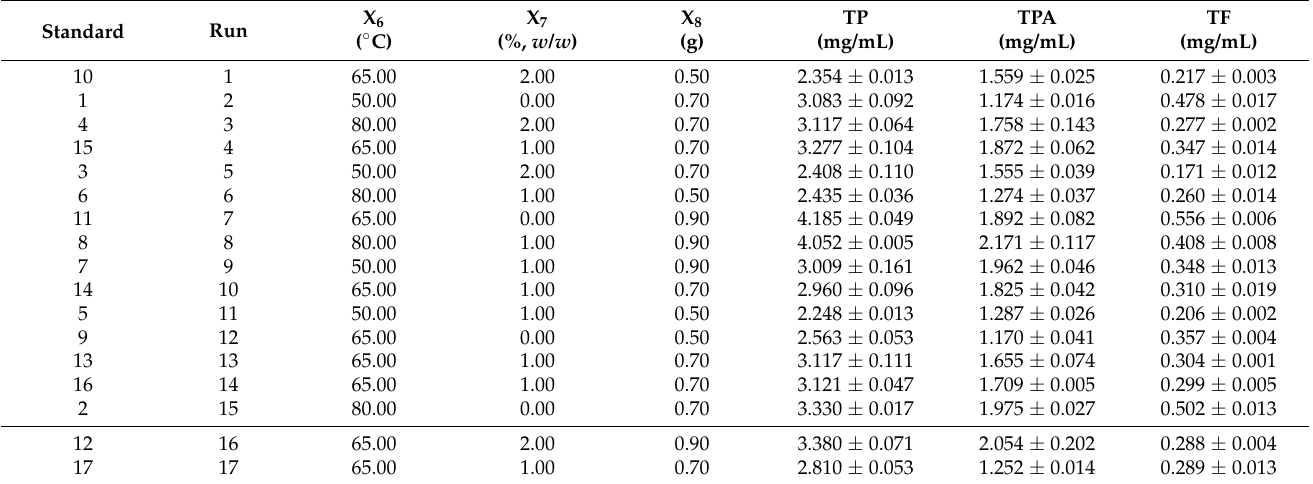
Table 4. Extraction conditions and content of total phenols (TP), phenolic acids (TPA), and flavonoids (TF) in the extracts prepared according to the Box–Behnken